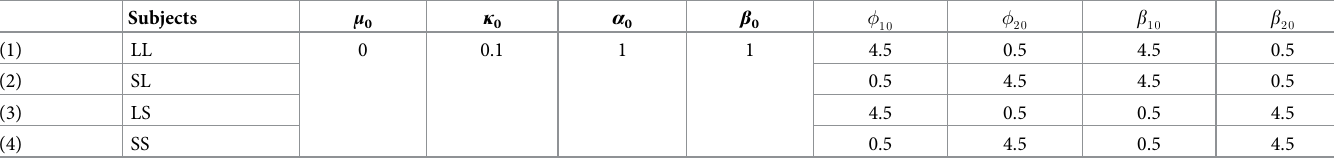
Table 2. This table summarizes the parameters of the beta prior of the two forgetting factors w and b used in the Learning and flexibility assessment section, as well as the initial prior over the mean and variance. A low value of initial number of observations κ 0 was used, in order to instruct learner to have a large prior variance over the value of the mean. Each subject will be referred by its expected memory at the lower and higher level (i.e. L = long, S = short memory). For instance, the subject number 3 (LS) is expected to have a long first-level memory, but a short second-level memory, which should make her more flexible than subject 2 (SL) after a long training, whom has a short first-level memory but a long second-level